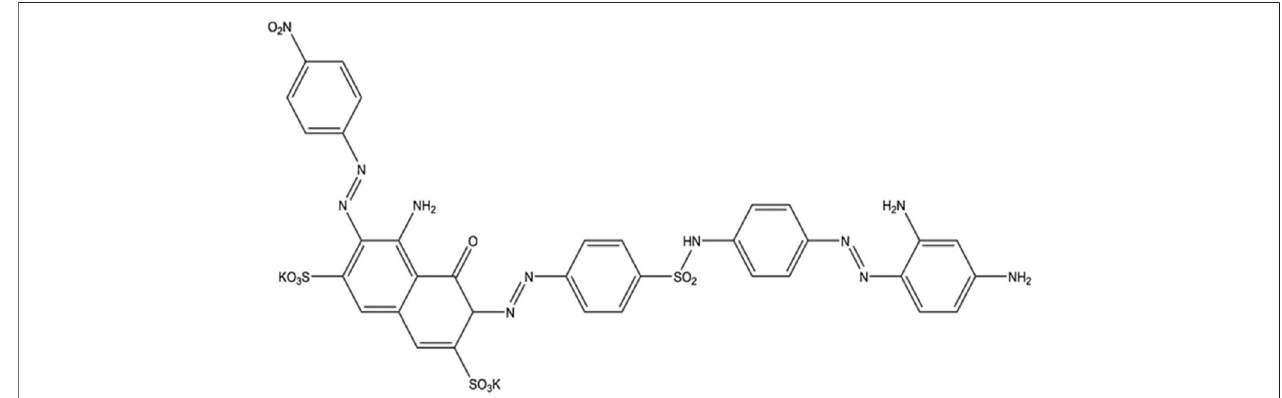
FIGURE 1 | Chemical structure of the